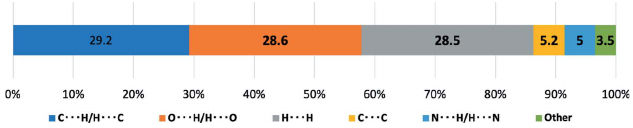
Figure 7 Percentage contributions of contacts to the Hirshfeld surface in the title